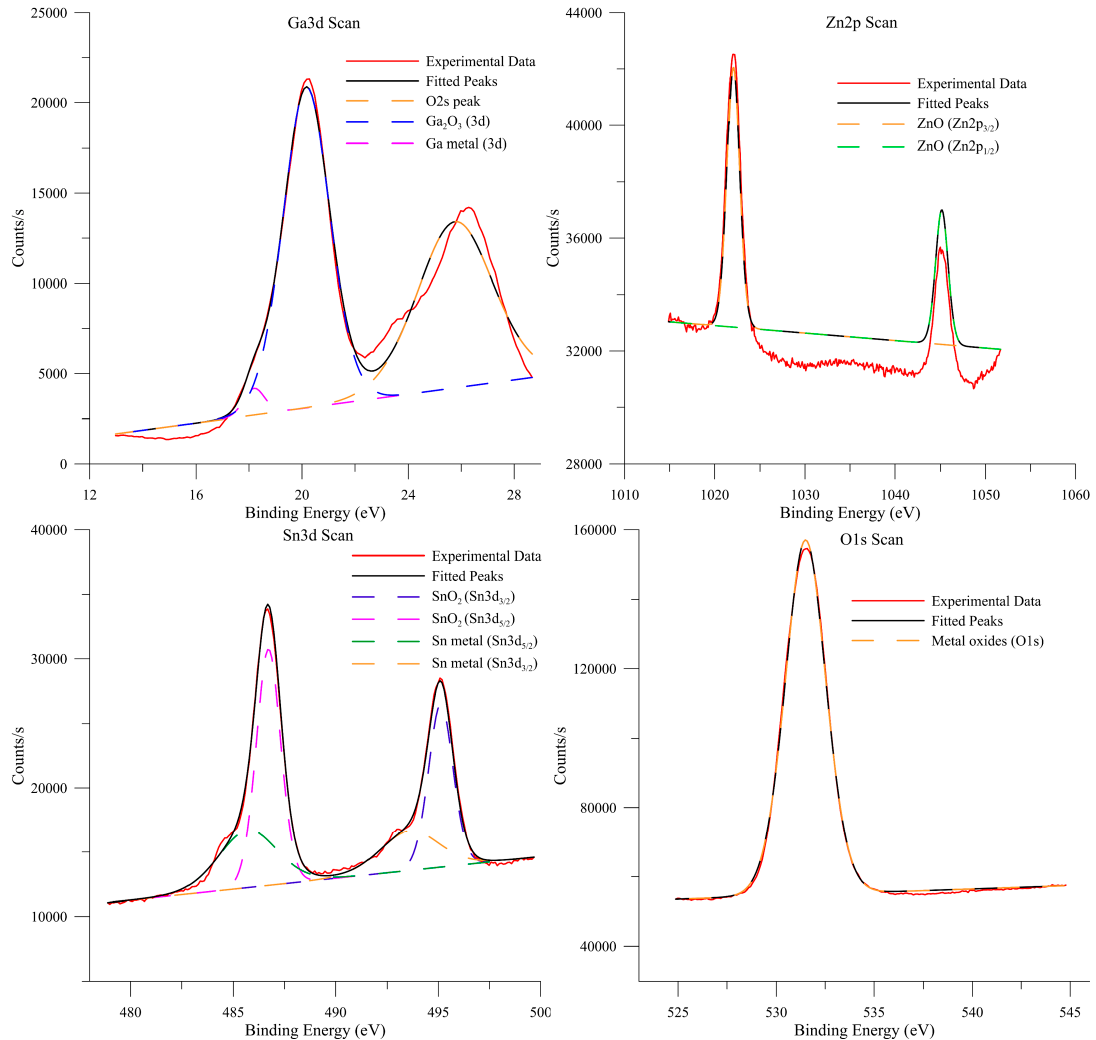
Figure 4. XPS spectra of Ga, Zn, Sn and O in oxide layers obtained from Ga–Sn–Zn eutectic alloy.